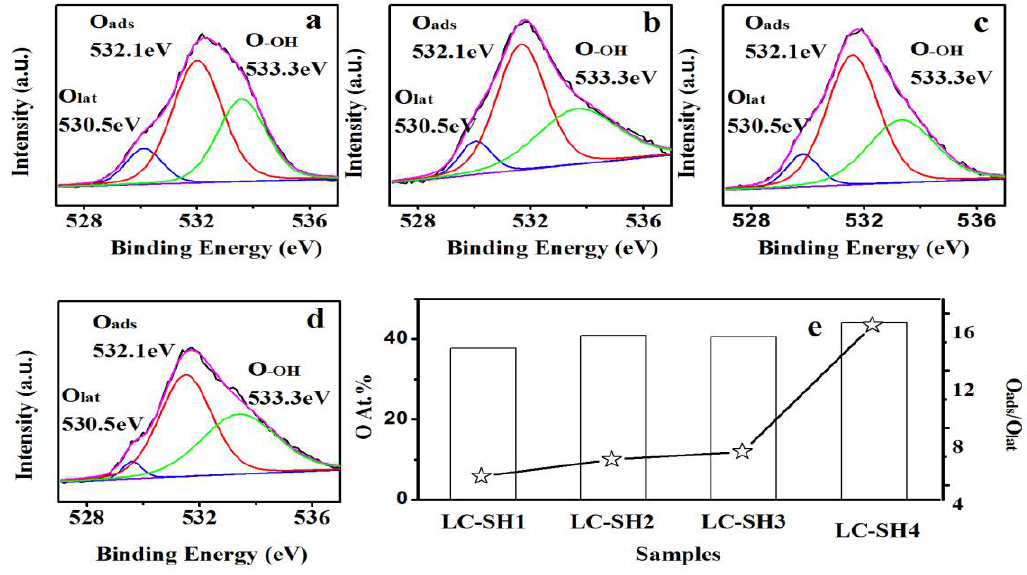
Figure 10. O 1s XPS spectra of catalysts with different amounts of nitrogen. ( a ) LC-SH1; ( b ) LC-SH2; ( c ) LC-SH3; and, ( d ) LC-SH4.